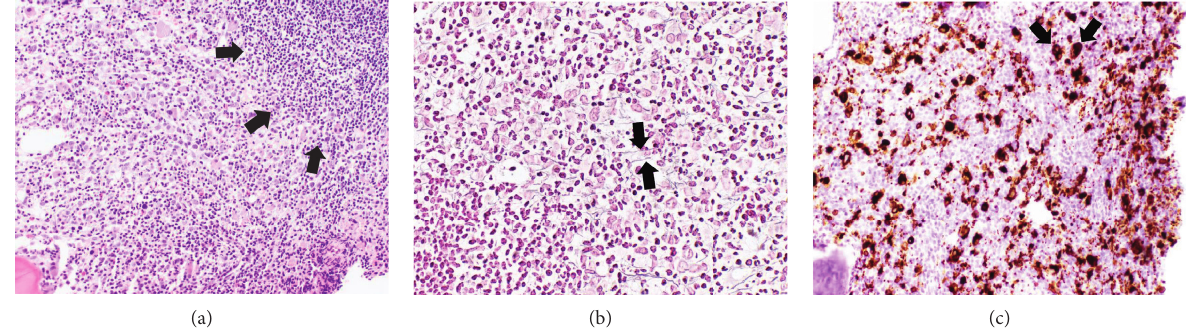
Figure 1: (a) Hypercellular bone marrow core biopsy with lymphocytic infiltrate (arrows) and a few dysplastic cells (hematoxylin-eosin). (b) Reticulin stain demonstrates increased reticulin fibers (arrows). (c) Immunohistochemical staining for CD61 reveals numerous CD61- positive immature cells with megakaryocytic differentiation